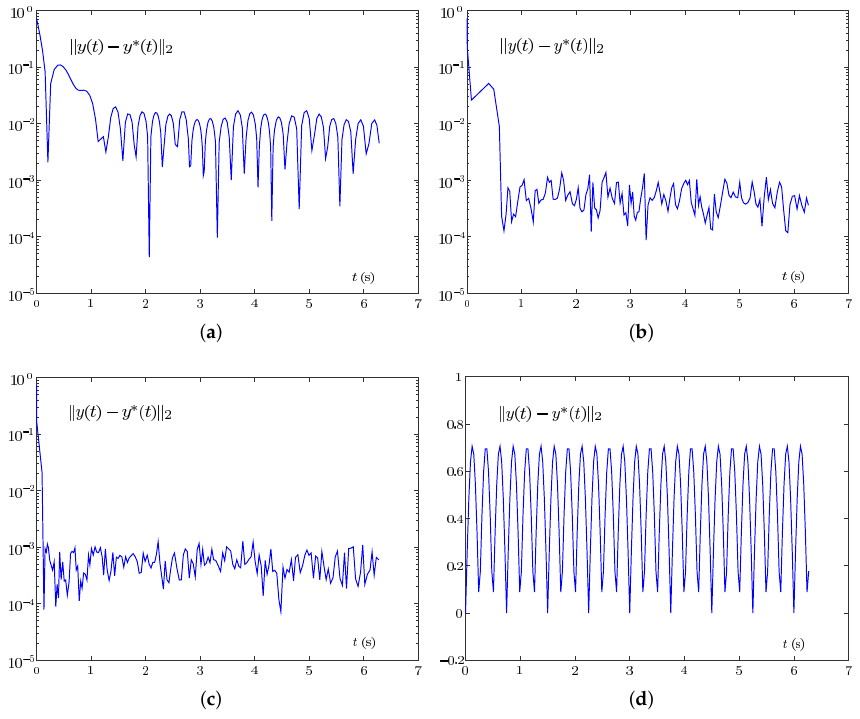
Figure 9. Dynamic characteristics of the (cid:107) y ( t ) − y ∗ ( t ) (cid:107) 2 by the two FPDP models, VPDP model, and the pseudo-inverse method with noise η l ( t ) = sin ( 4 π t + π ) . ( a ) FPDP model with AF (5). ( b ) FPDP model with AF (10). ( c ) VPDP model with AF (12). ( d ) The pseudo-inverse